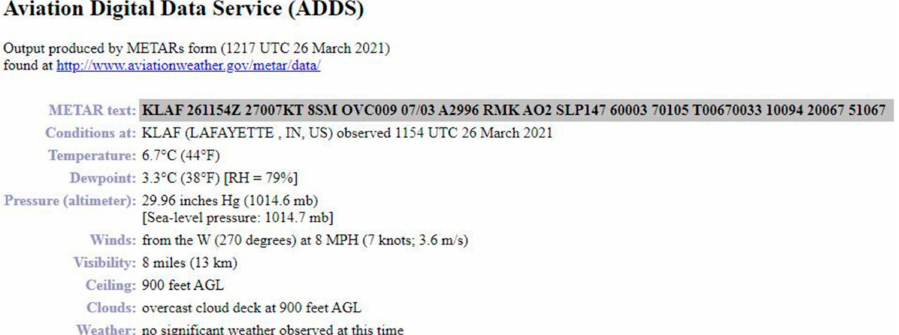
Figure 4. Example METAR Aviation Weather Report from